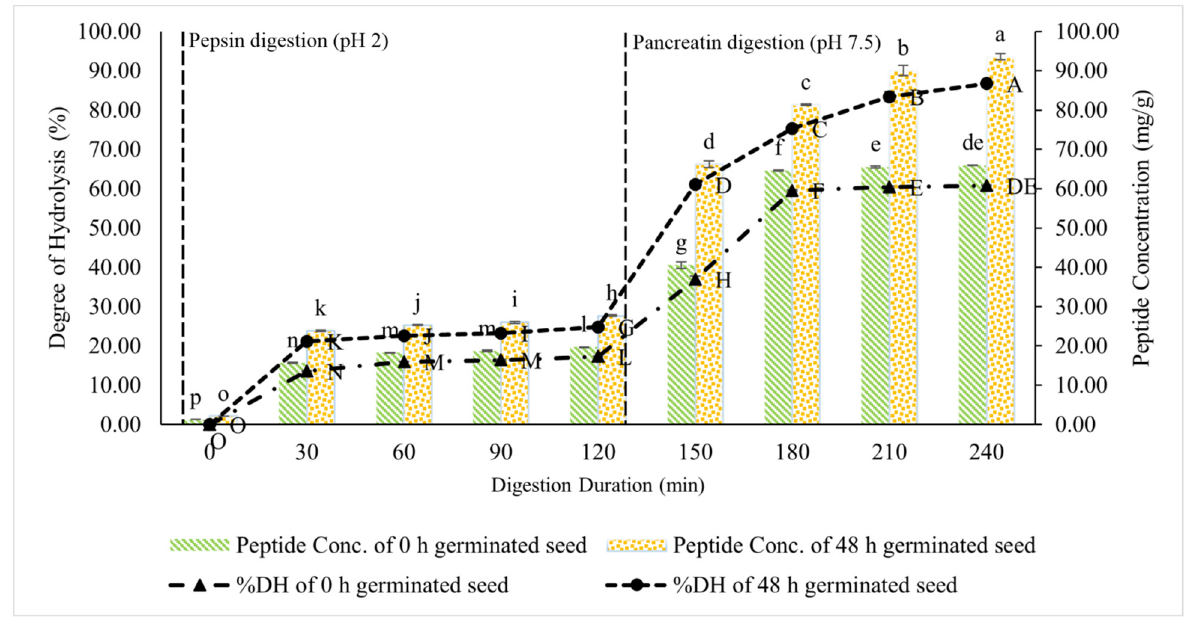
Figure 1. %DH and the peptide concentration of the germinated lamtoro gung flour at different digestion durations. Values are means with their SDs. Capital letters indicate significant differences between the samples of the %DH, and the small letters indicate significant differences between the samples of the peptide concentration (Duncan’s test, α = 0.05).